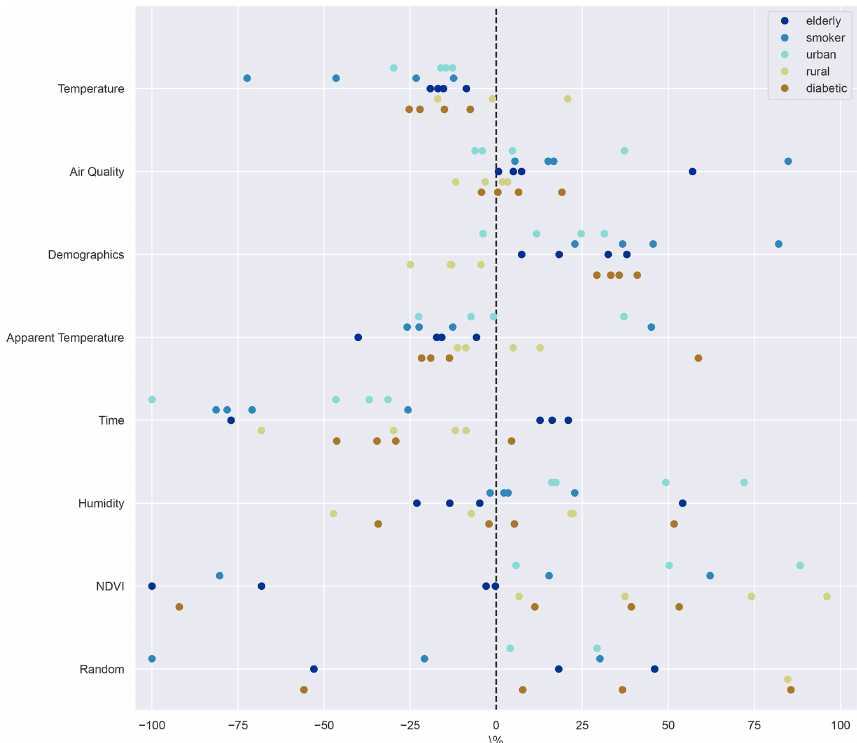
Figure 6. Change in feature importance for predicting MI in percent relative to the general population for every subgroup considered. Related features have been grouped